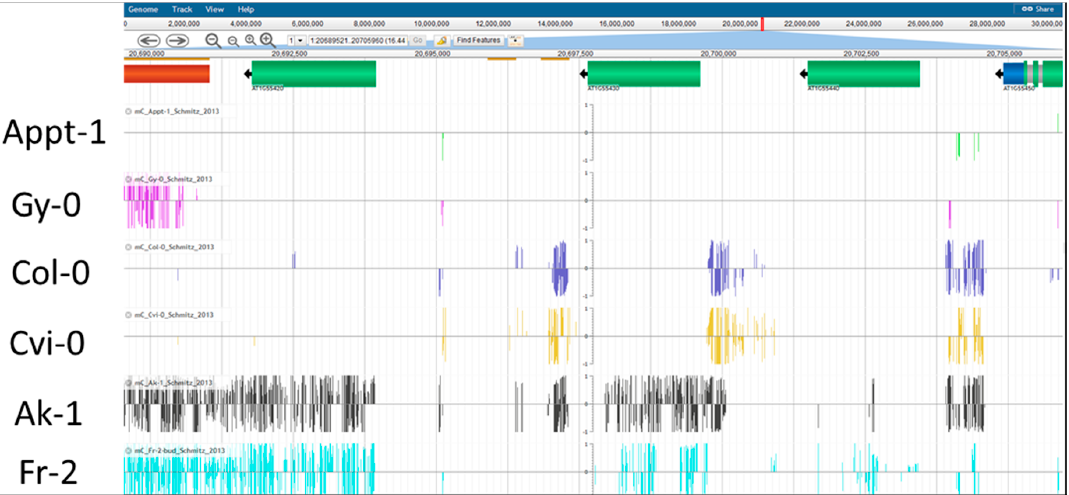
Figure 4. DNA methylation in the QTL region. Appt-1 and Gy-0 represent accessions without detectable cytosine methylation in the promoter regions of AT1G55420 , AT1G55430 and AT1G55440 . Col-0 and Cvi-0 represent the majority of accessions with a typical DNA methylation pattern in the promoter regions of the respective genes. Ak-1 and Fr-2 are special accessions with gene body specific DNA methylation detected.